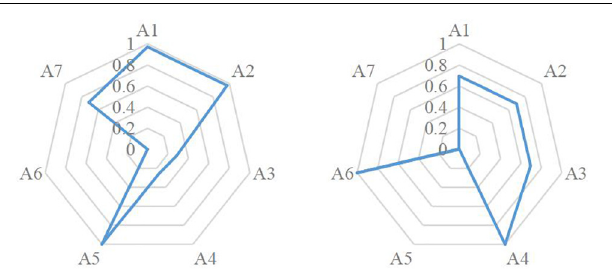
FIGURE 2 | Person parameter estimation specifications of students No.15 and No.26. maps in Figure 2 depicted two students’ (student No. 15 on the left and student No. 26 on the right) mastery information on each attribute, both students scored 13 in the diagnostic checklist, but their weaknesses and strengths were quite different. For student No. 15, A1, A2, and A5 were the strongest attributes while A6 was the weakest one. However, for student No. 26, A4, and A6 were the strongest attributes while A7 was the weakest one.